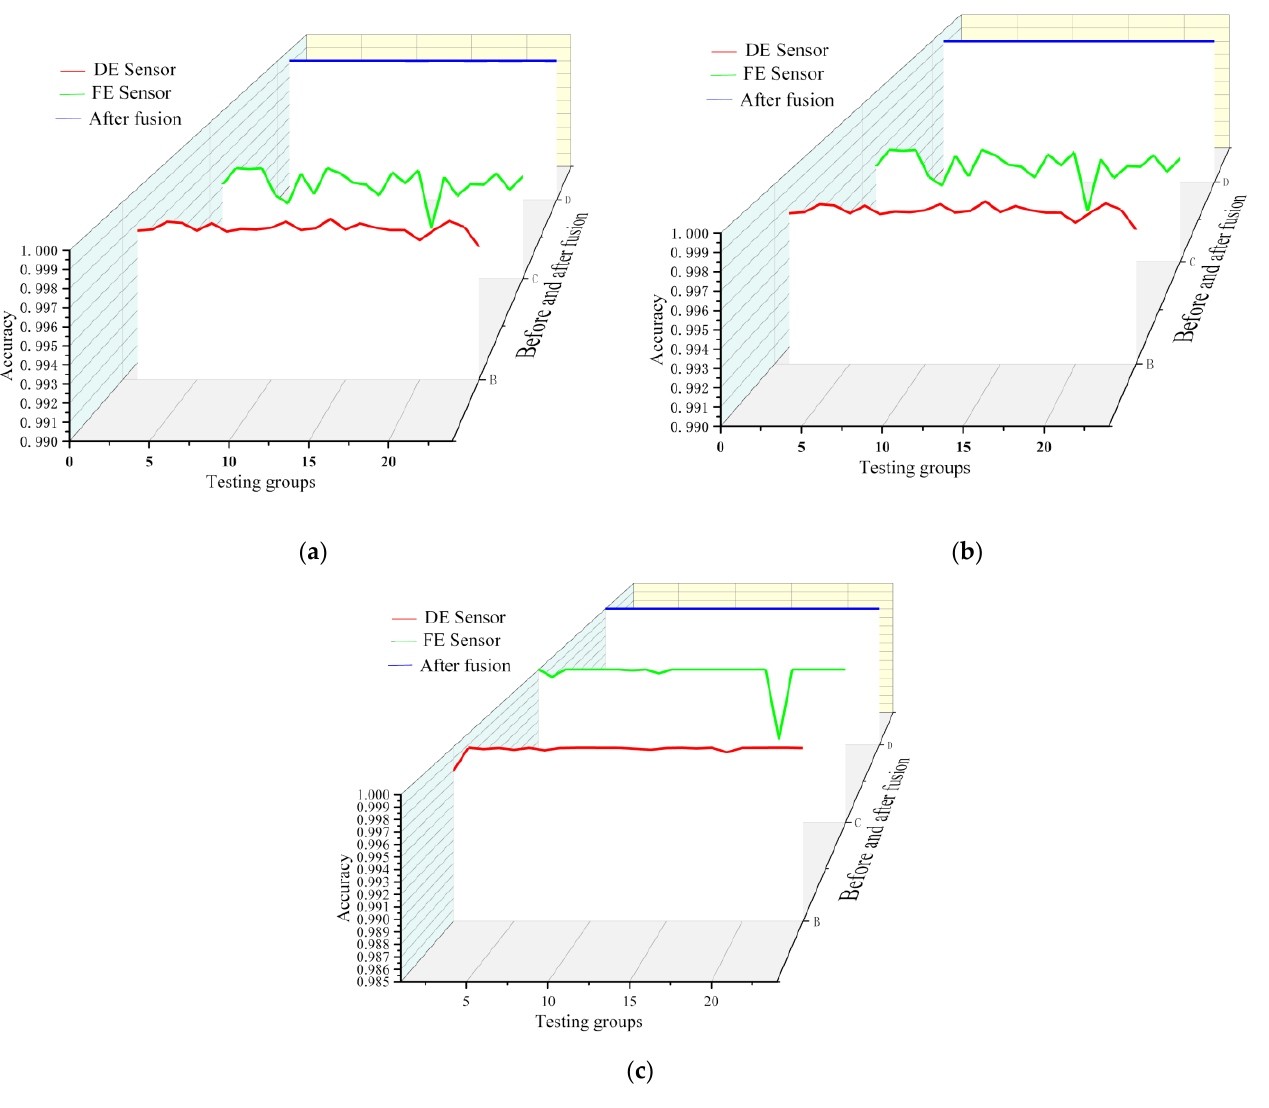
Figure 8. Comparison before and after the fusion of machine learning and deep learning. ( a ) BP algorithm multi-sensor fusion. ( b ) GA-BP algorithm multi-sensor fusion. ( c ) VGG16 algorithm multi-sensor fusion.